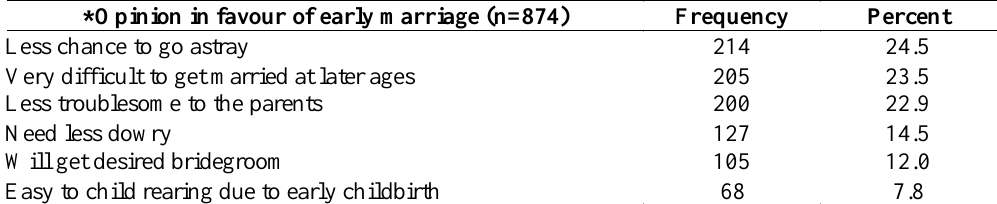
Table IV : Adolescents opinion not in favour of early marriage *Opinion not in favour of early marriage (n=2488)